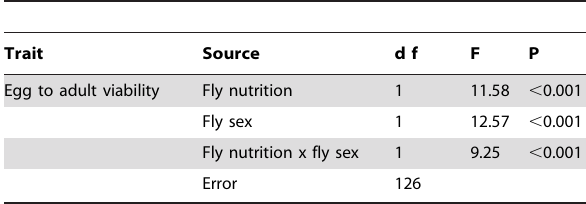
Table 1. Two – way ANOVA for egg to adult viability in either protein or carbohydrate-enriched